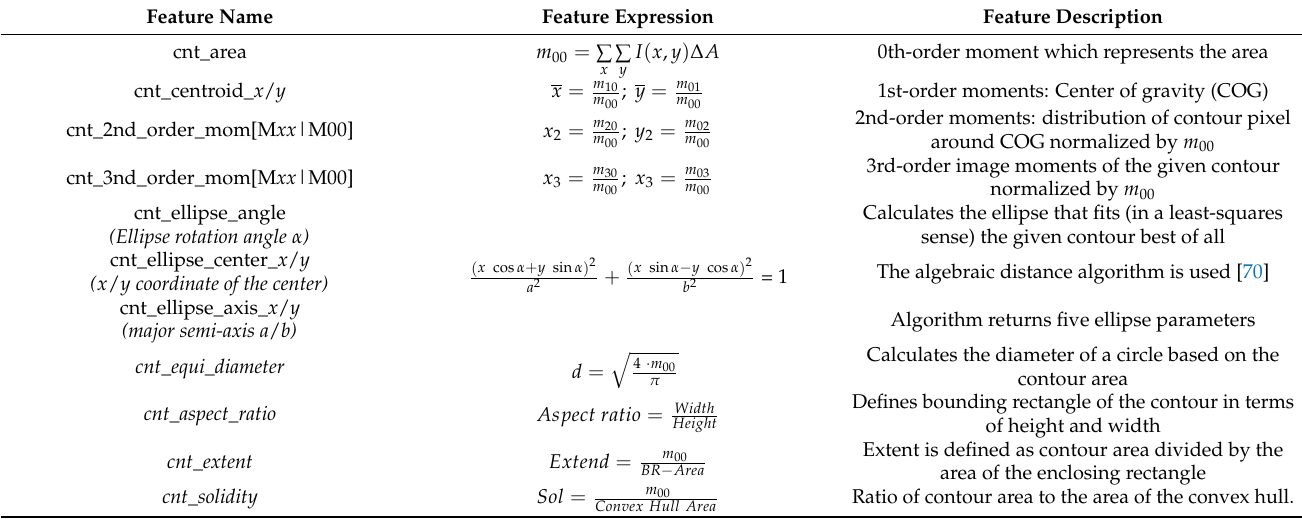
Table A1. Features based on shape descriptors and image moments (geometrical features) for a given keyhole or weld pool